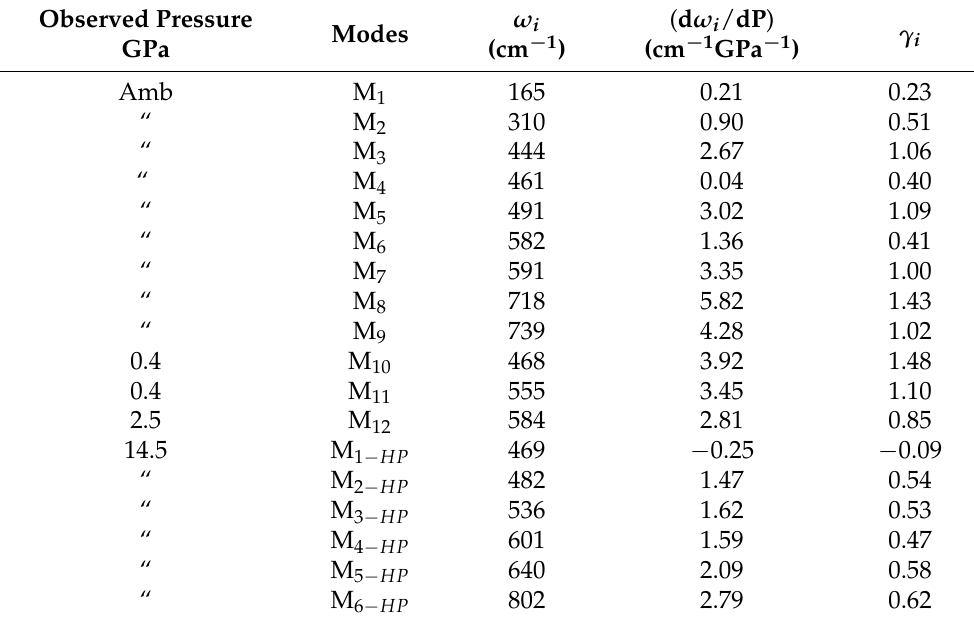
Table 7. Pressure at which the modes are observed, frequency ω i of observed Raman modes, pressure coefficients d ω i /dP of Raman modes, and mode Grüneisen parameter γ i (see